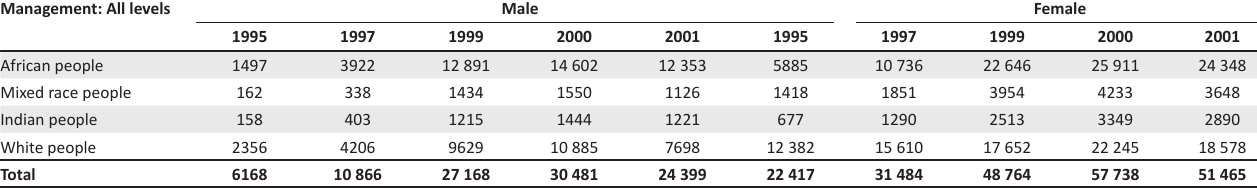
TABLE 1: Under-representation of women at managerial level per race group: